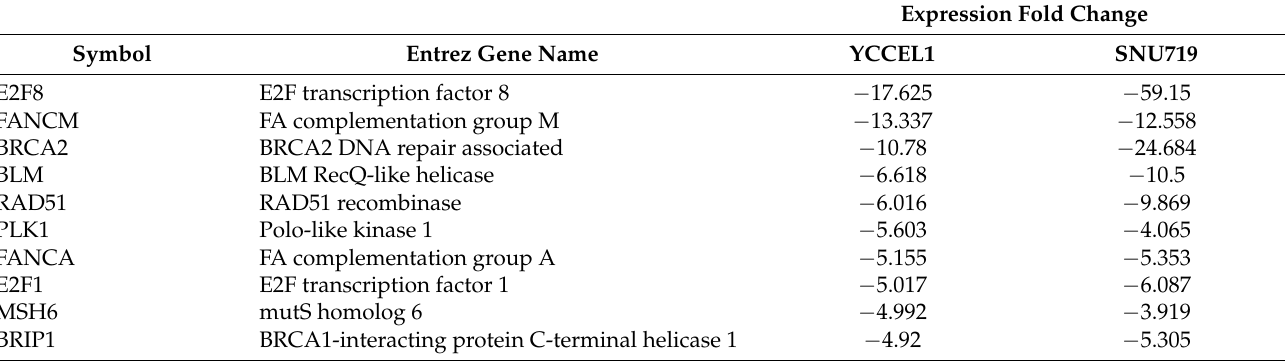
Table 1. Change of gene expression of pathway “role of BRCA1 in DNA damage response”.